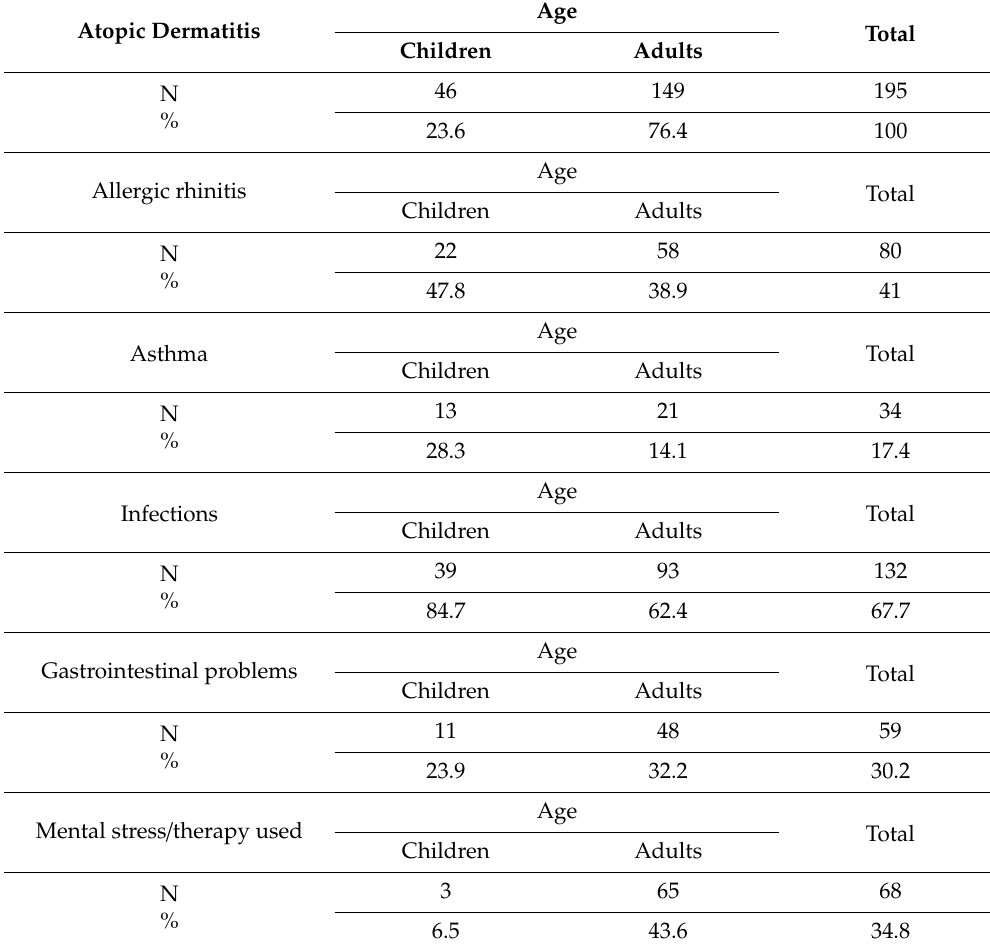
Table 3. The incidence of atopic dermatitis and comorbid diseases in relation to the patients’ ages. Atopic Dermatitis